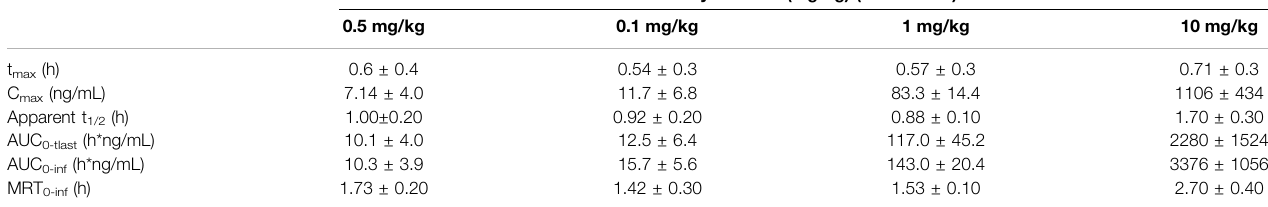
TABLE 10 | Calculated pharmacokinetic measures for